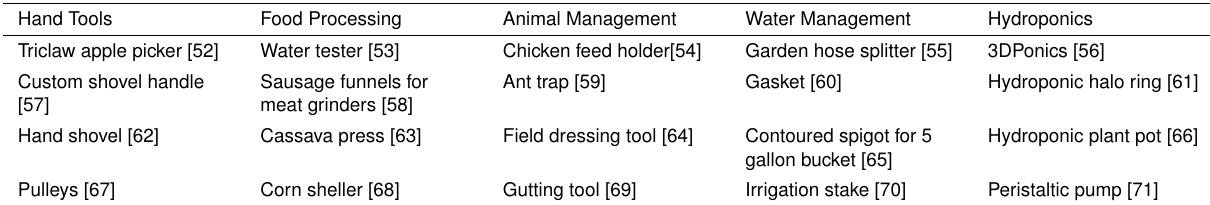
Table 1. Selected and categorized 3-D printable objects useful for organic farming.